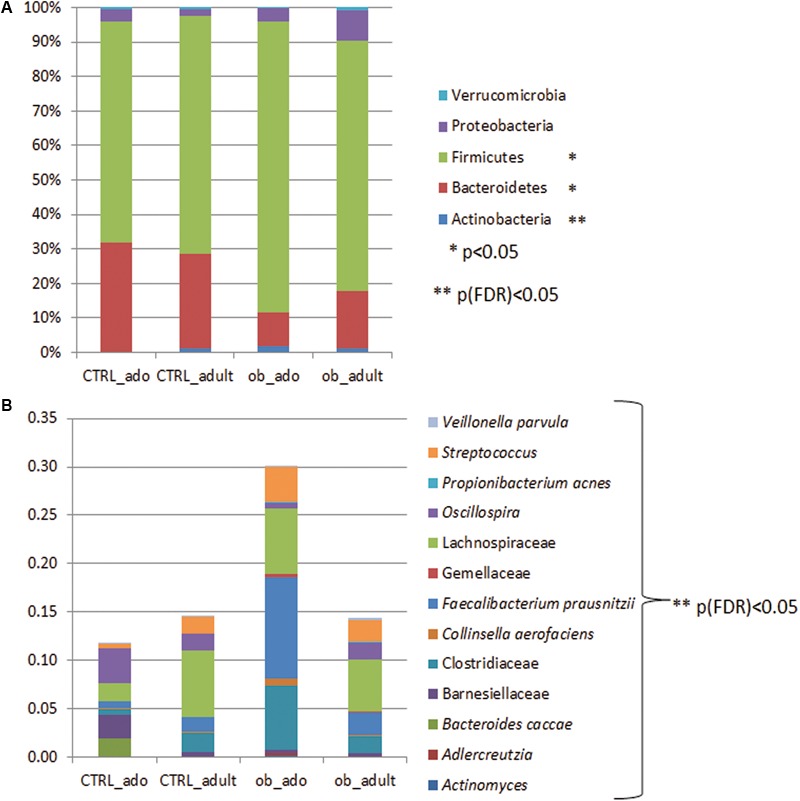
Bar chart representing Kruskal–Wallis test results on operational taxonomic units (OTUs) grouped in phyla (A) and in families/species (B) of the CTRL_ado, CTRL_adult, ob_ado, ob_adult groups. Each column in the plot represents a group, and each color in the column represents: (A) the percentage of relative abundance for each OTU; (B) the values of relative abundance for each OTU.